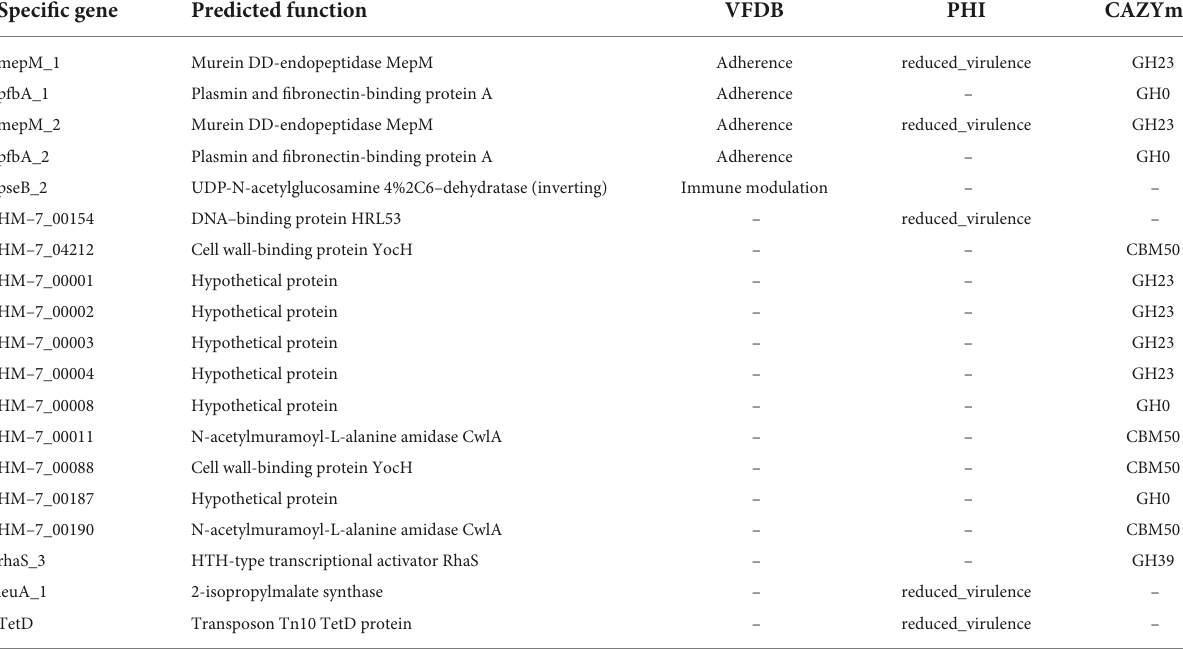
TABLE 2 The annotation of 19 specific-genes in HM-7 against the VFDB, PHI, and CAZYmes databases. Specific